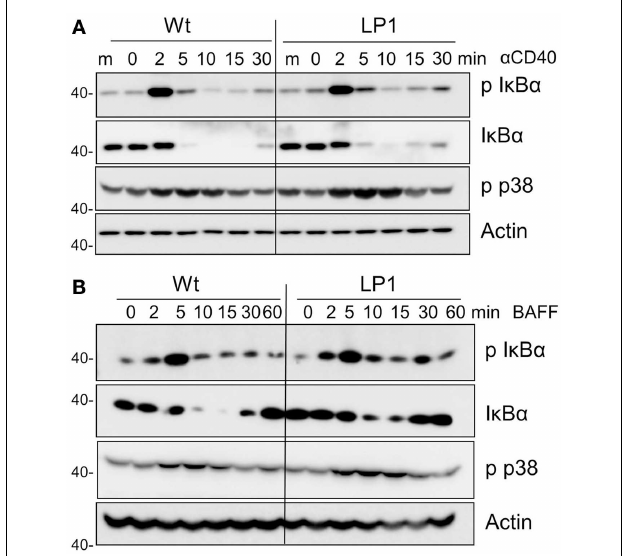
FIGURE 3 | Impact ofTRAF3 on CD40 and BAFFR-mediated NF- κ B1 and p38 MAP kinase activation . CH12.TRAF3 − / − cells were induced to express Wt or mutant LP1TRAF3 as in Figure 1 . Cells were stimulated as described in Figures 2C,D via CD40 (A) or BAFFR (B) , and immunoblots of whole cell lysate samples were probed for phosphorylated I κ B α (p I κ B α ), total I κ B α , phospho p38 (p-p38), and actin (used as a control for p-p38 because antibodies to total p38 also recognize the phosphorylated form). Representative blots from three independent experiments are